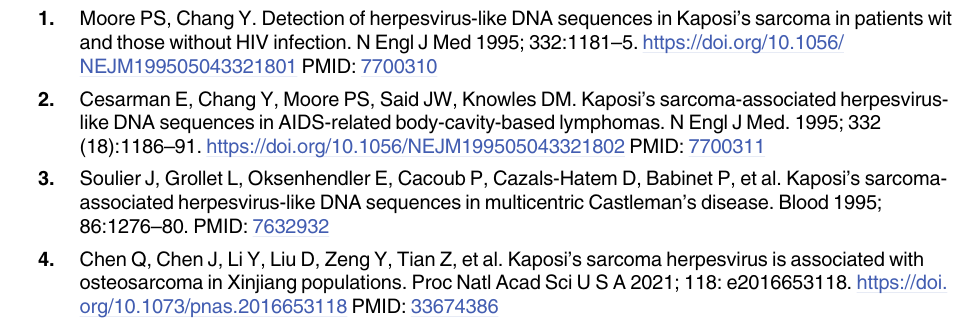
S3 Fig. Blockade of vGPCR-VEGF-A axis using a neutralizing antibody against VEGF-A inhibits PROX1 activation and KSHV-promoted angiogenesis and invasion phenotypes. (A) PDLSCs were treated with conditioned medium from KSHV-PDLSC. The expression of PROX1 and PDPN were analyzed by Western blot. (B) KSHV-infected PDLSCs (K-PDLSCs) were placed on Matrigel, and tubulogenesis was examined by Tubule formation assay and quantified by measuring the total segment tube length using the ImageJ software. (C) K-PDLSCs (1.5x10 4 cells/well) were seeded in the upper chamber of Transwell with Matrigel in serum-free α -MEM. α -MEM containing 20% FBS was used as a stimulus for chemotaxis in the lower chamber. Cells migrated to the lower chamber were stained with crystal violet. The error bars represent SD. Statistics analysis was performed using t-test in GraphPad Prism. P- values < 0.05 were considered significant ( � P < 0.05, �� P < 0.01 and ��� P < 0.001) and N.S repre- sented no